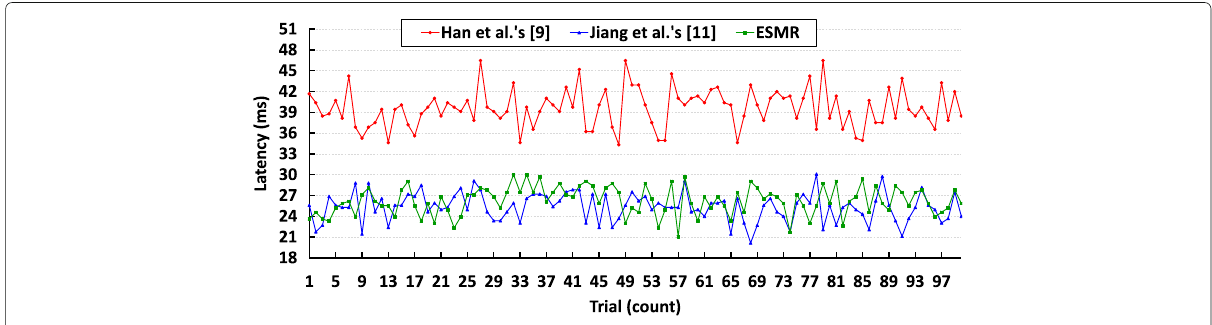
Fig. 8 Reauthentication latency when n = 5